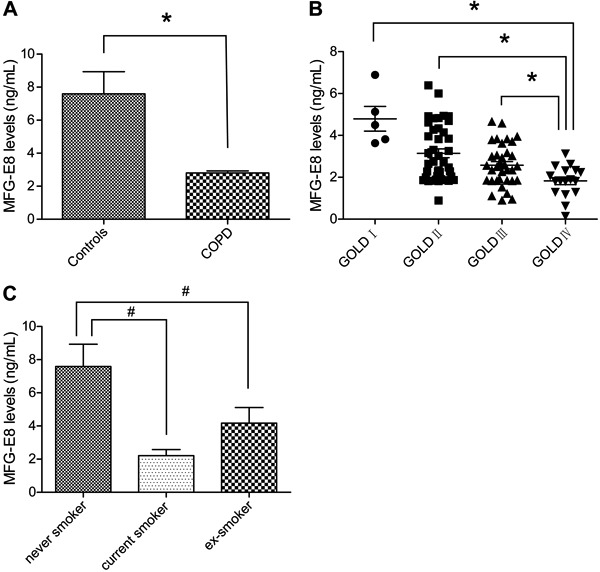

A, Plasma milk fat globule epidermal growth factor 8 (MFG-E8)
levels in healthy controls and patients with chronic obstructive pulmonary
disease (COPD). B, Plasma MFG-E8 levels in COPD patients
differing in the severity of their disease. Global Initiative For Chronic
Obstructive Lung Disease (GOLD) criteria: GOLD I (mild); GOLD II (moderate);
GOLD III (severe); GOLD IV (very severe). C, Plasma MFG-E8
levels among never, current, and ex-smokers. A: *P<0.05
vscontrol; B: *P<0.05
vs GOLD IV; C: #P<0.05
vs never smoker (Mann-Whitney U-test was
used to compare two groups and Kruskal-Wallis H test was used to compare more
than two groups).